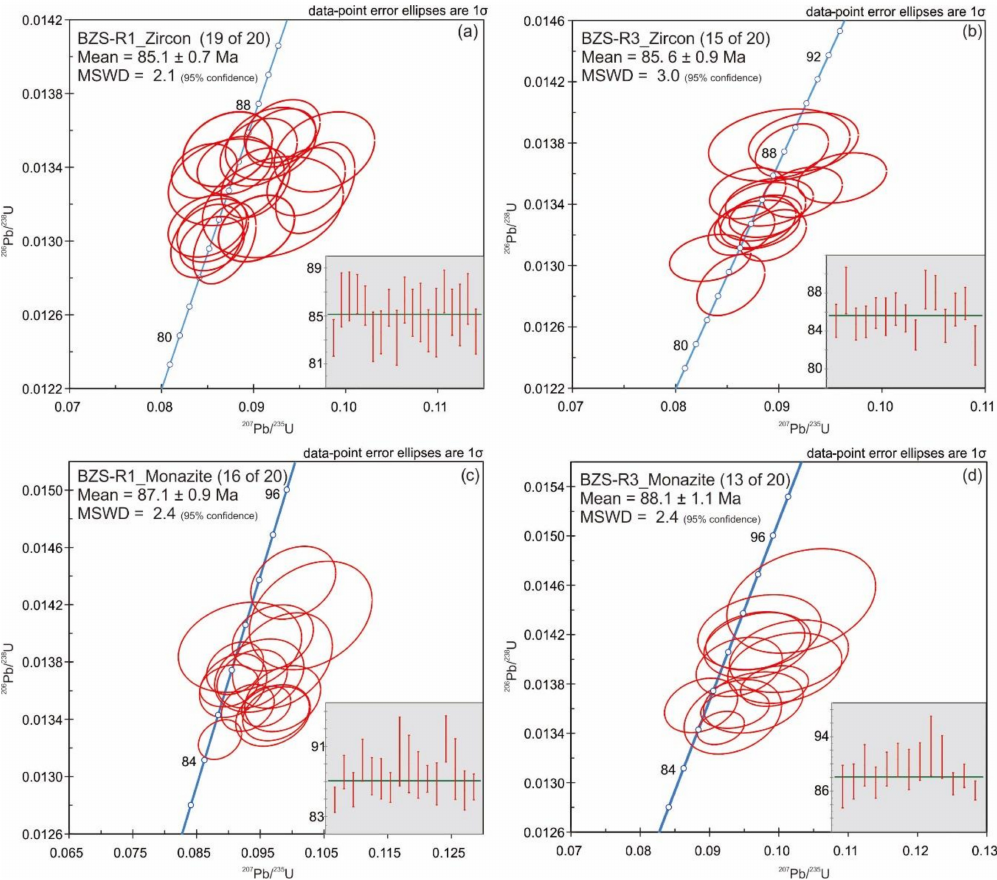
Figure 5. ( a , b ) LA-ICP-MS zircon U–Pb concordia diagrams for the Bozhushan batholith. ( c , d ) LA-ICP-MS monazite U–Pb concordia diagrams for the Bozhushan batholith. The age data and concordia plots were reported at 1 σ error, whereas the uncertainties for weighted mean ages are given at a 95% confidence level. Table 1. LA-ICP-MS zircon U–Pb isotopic data of the Bozhusuan batholith. Spot